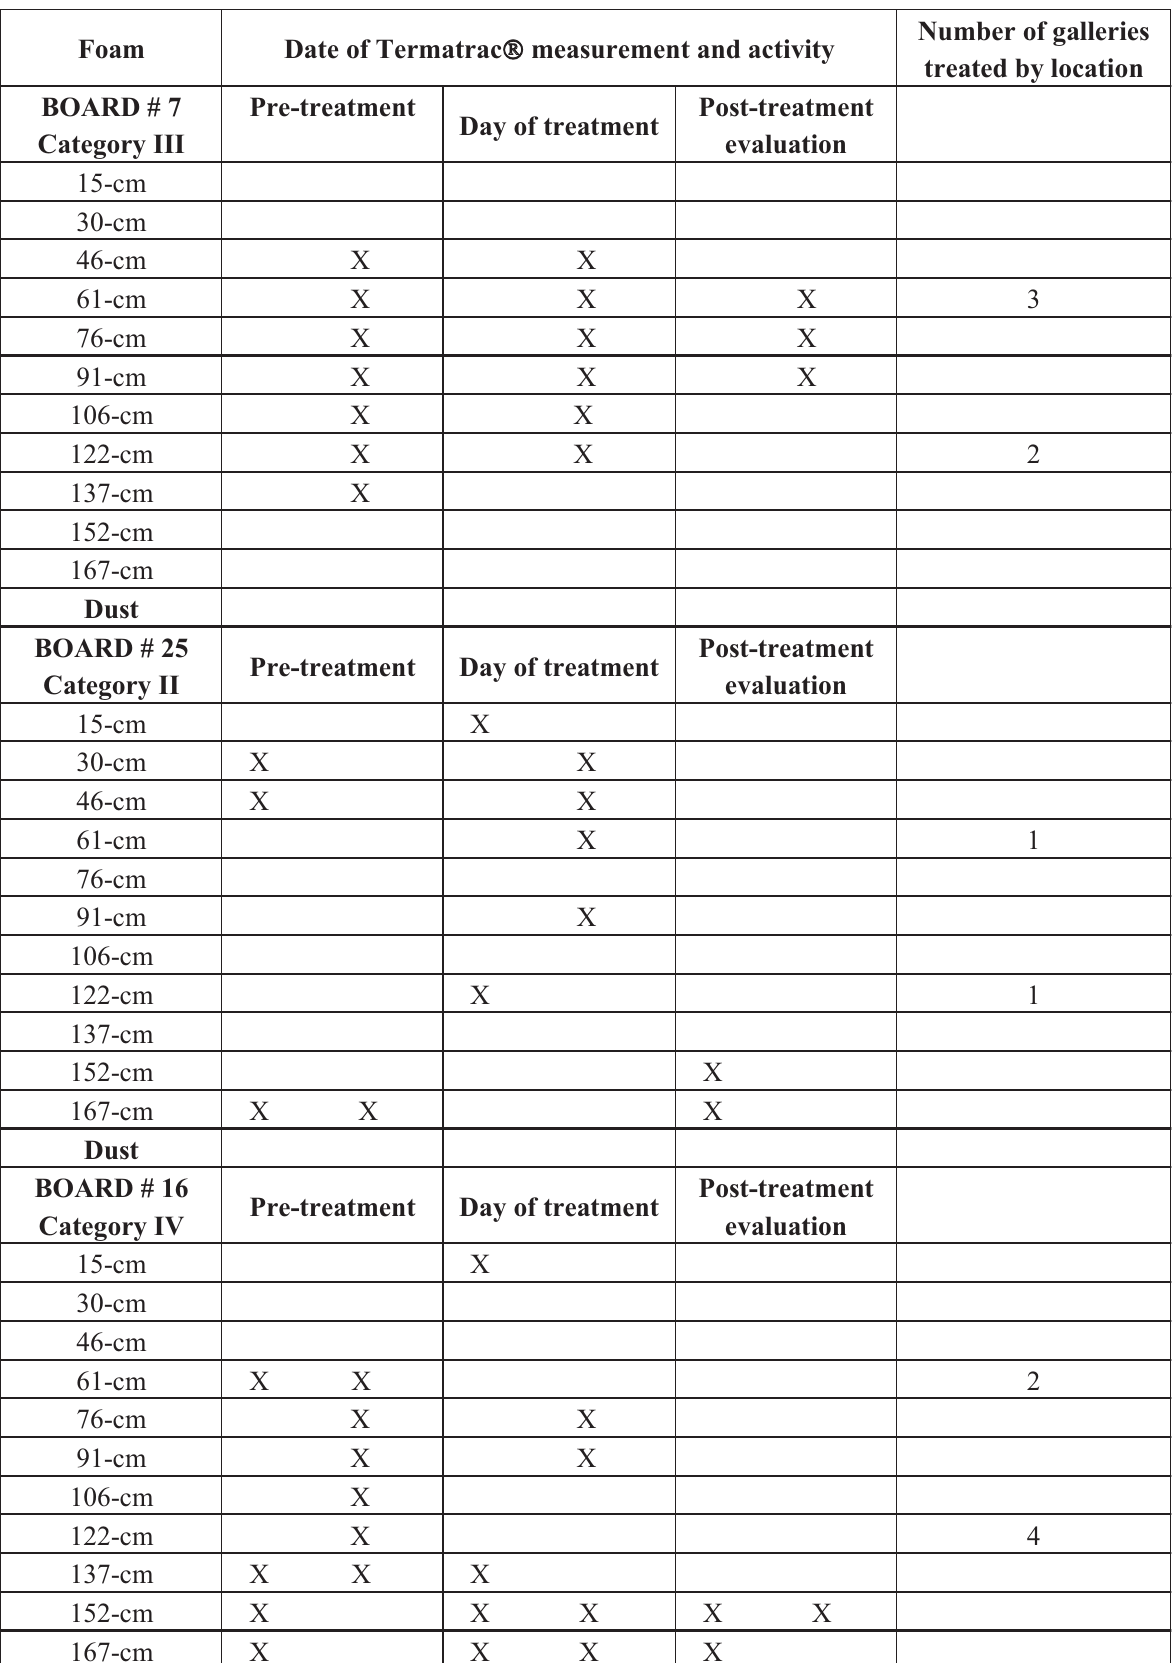
Date of Termatrac (cid:2)(cid:2) measurement and